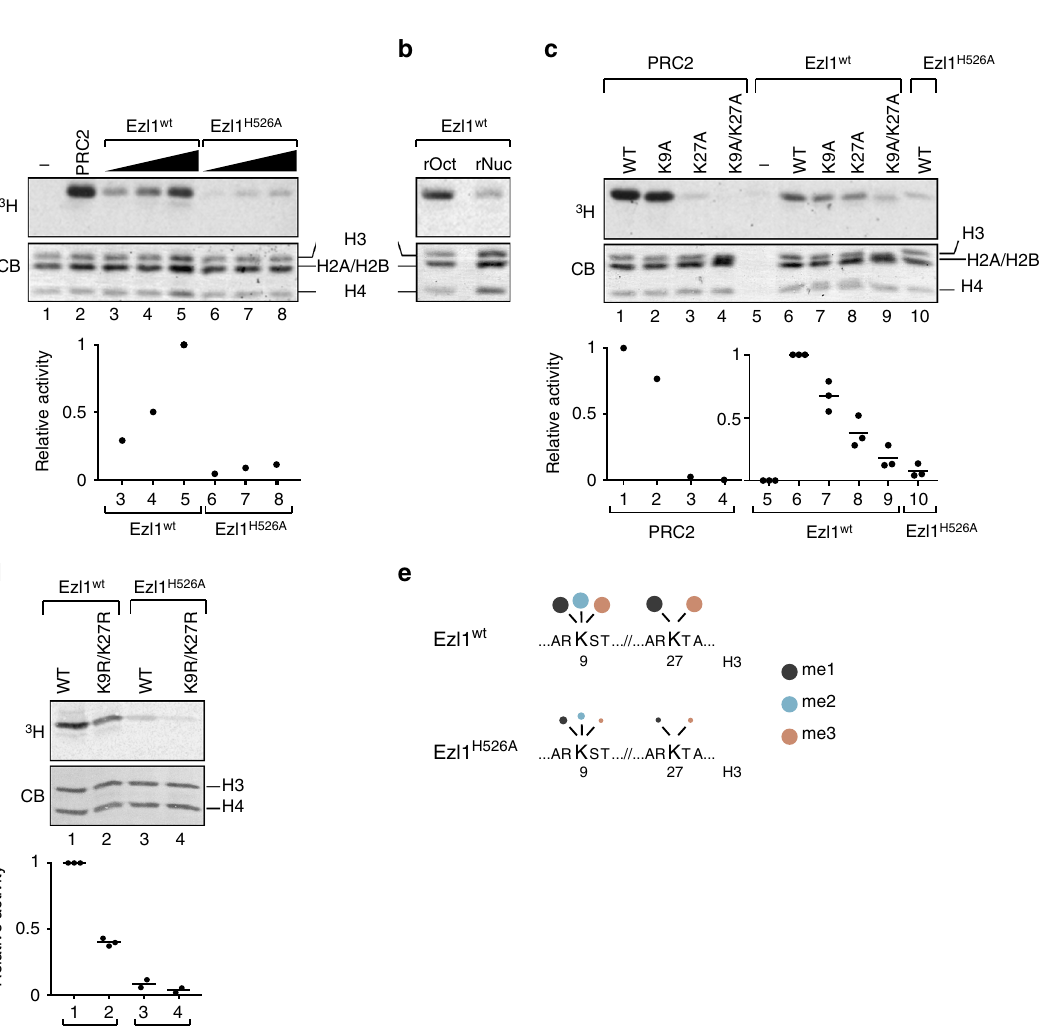
and H3K27me3 deposition were assayed by immunostaining with anti-H3K9me3 and anti-H3K27me3 antibodies, respectively. Recovery of viable sexual progeny after sexual events was measured by transferring individual autogamous cells to fresh growth medium and letting them resume vegetative growth. In